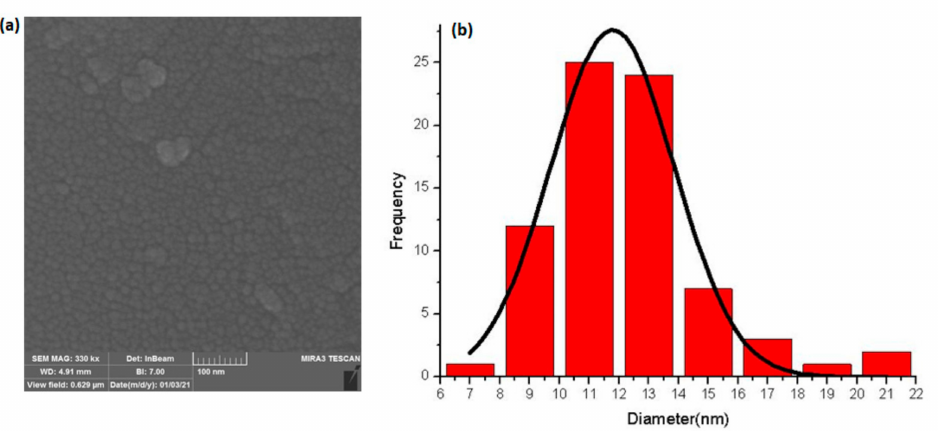
Figure 1. ( a ) FESEM images of iron-carbon nanohybrid ( b ) the particle size distribution of nanohy- brid